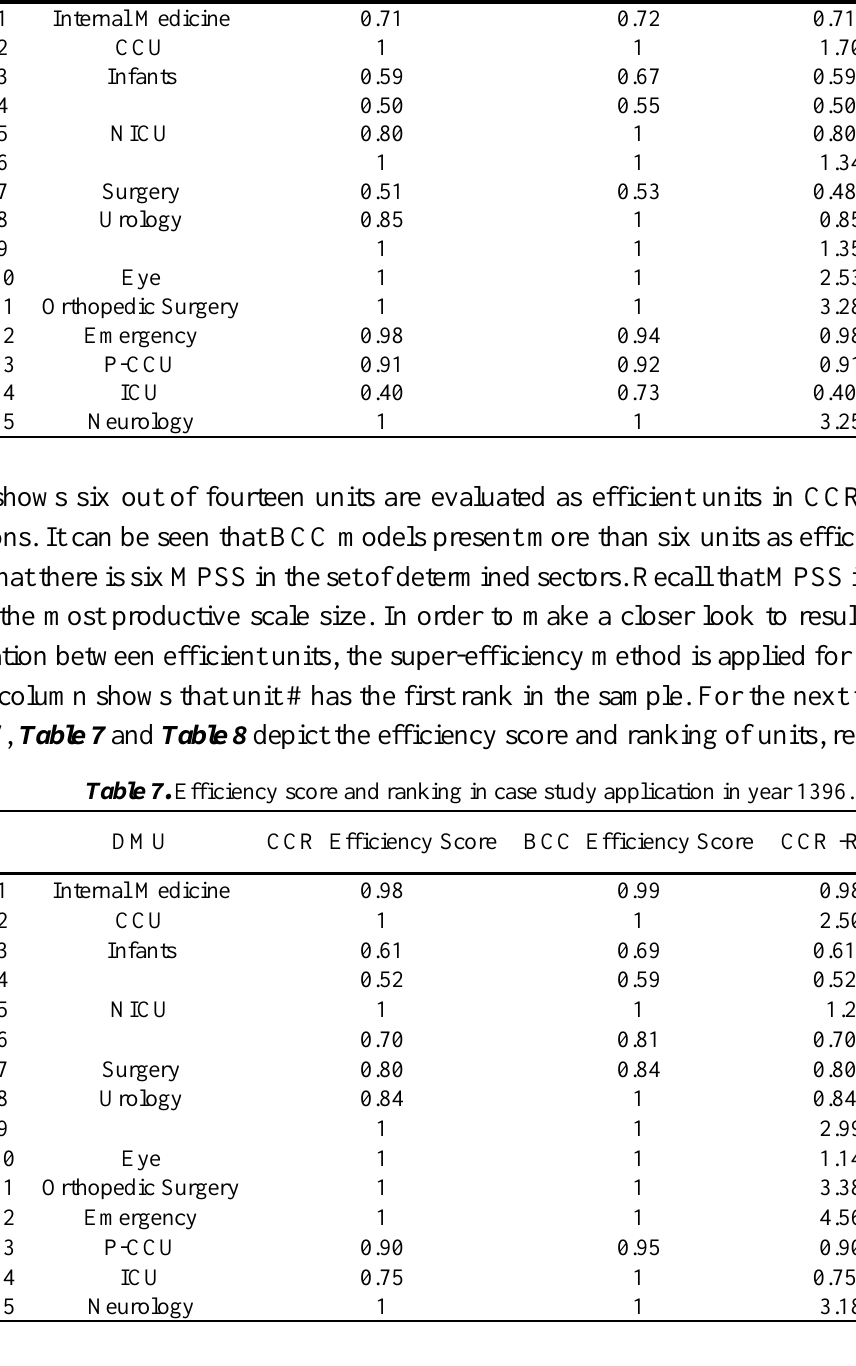
Table 7 represents seven efficient units in CCR model and nine efficient units in BCC